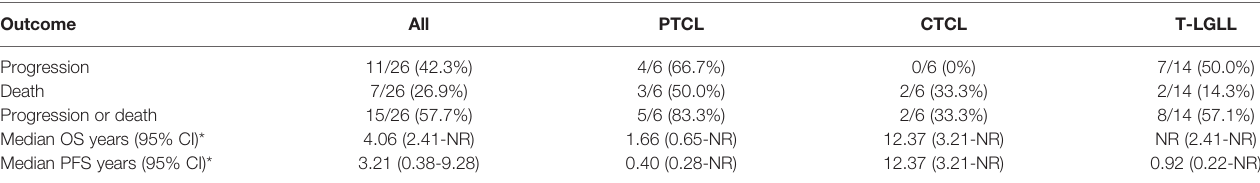
TABLE 4B | Progression and survival